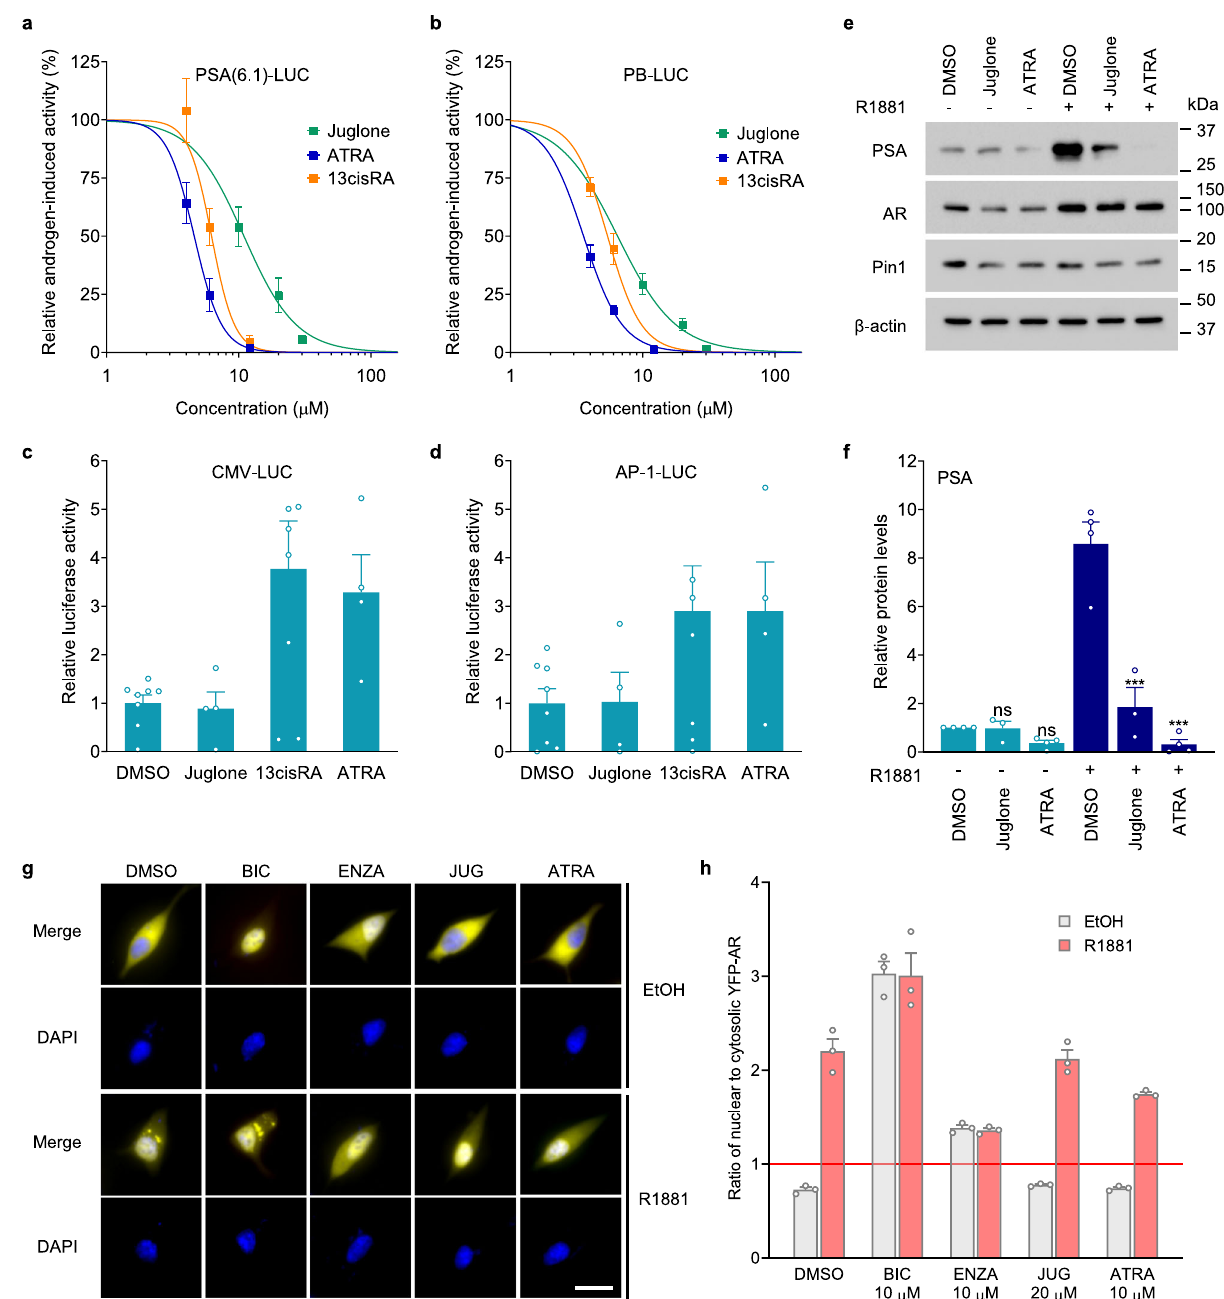
Fig. 2 Pin1 inhibitors block the transcriptional activity of AR. a , b Inhibitory dose – response curves for juglone, ATRA, and 13cisRA on the activity of PSA (6.1 kb)- and PB-luciferase in LNCaP cells stimulated with R1881 (1 nM) for 24 h. Data shown are normalized to the induction by R1881, which was 149-fold for PSA (6.1 kb)- and 1420-fold for PB-luciferase, n = 4 independent experiments. ( c , d ) Activities of CMV and AP-1 reporters after incubating with juglone (20 µ M), 13cisRA (10 µ M), ATRA (10 µ M), or vehicle (DMSO) for 24 h. Data shown represent the means ± s.e.m. from four independent experiments. e Western blot analysis of PSA, AR, and Pin1 protein levels from LNCaP cells treated with juglone (20 µ M) or ATRA (10 µ M), and 1 nM of R1881 or vehicle for 24 h. f Graph showing the quanti fi ed PSA levels after normalizing to β -actin. g Representative fl uorescence micrographs showing the localization of YFP-AR in LNCaP cells pre-treated with the indicated compounds and stimulated with R1881 (1 nM) or vehicle (EtOH) for 2 h. The scale bar represents 20 μ m. h YFP-AR localization was quanti fi ed by calculating the ratio of average YFP intensity in the nucleus compared to the cytosol. Scores greater than 1 indicate nuclear localization. At least 50 cells were scored for each treatment. Data shown are the normalized means± s.e.m. from three independent experiments. Statistical signi fi cance was determined by one-way ANOVA using Holm-Sidak ’ s multiple comparisons test. *** P < 0.001; ns not signi fi